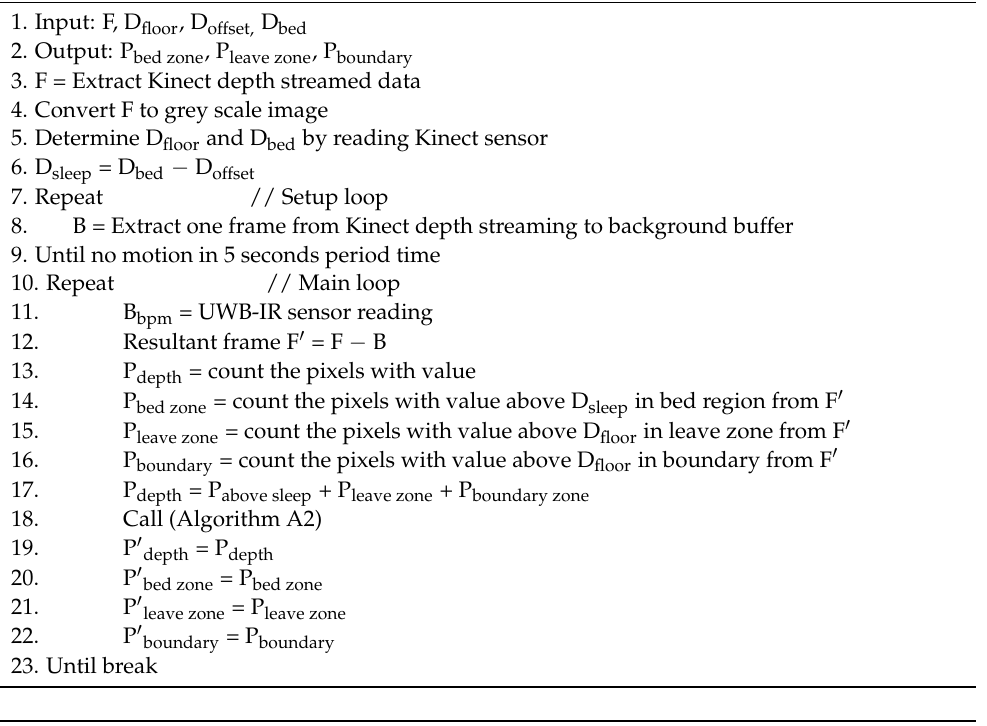
Algorithm A1 Streamed data